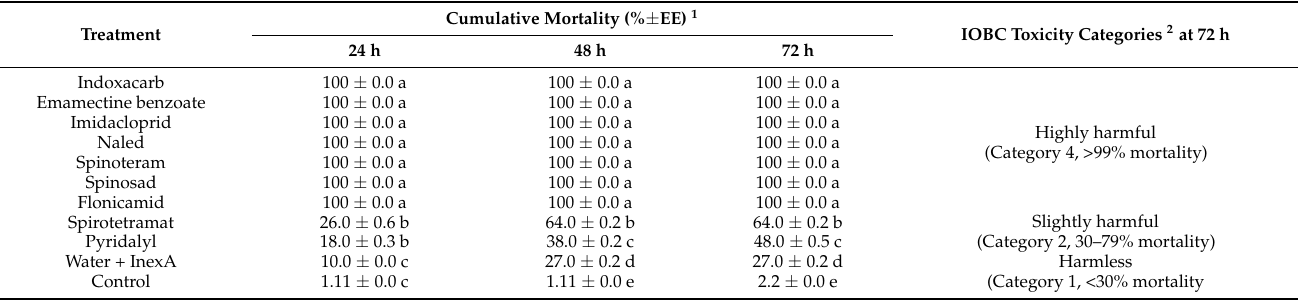
Table 2. Diadegma insulare mortality 24, 48, and 72 h after insecticide application.